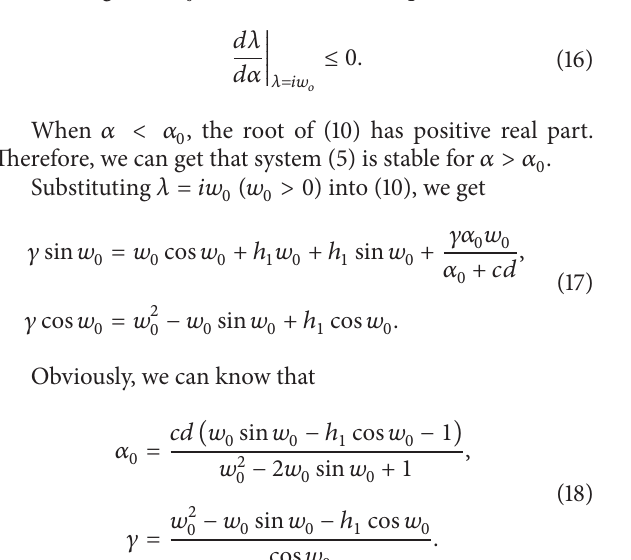
Substituting 𝜆 = 𝑖𝑤 0 ( 𝑤 > 0 ) into above equation, we have